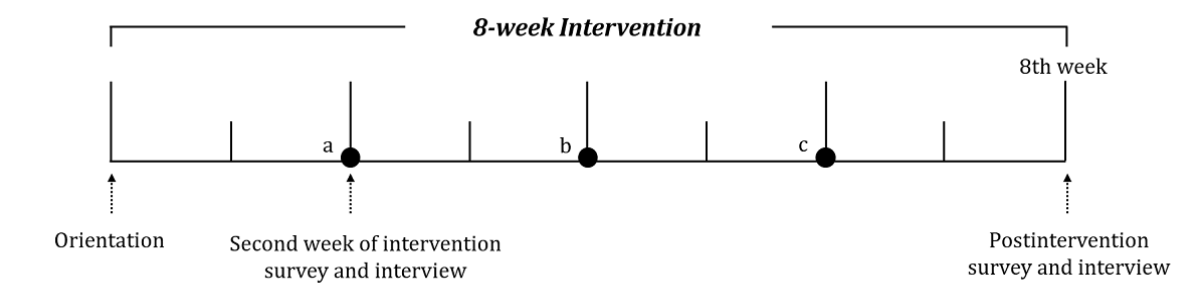
Figure 3. Timeline of the usability study. a,b,c: biweekly face-to-face